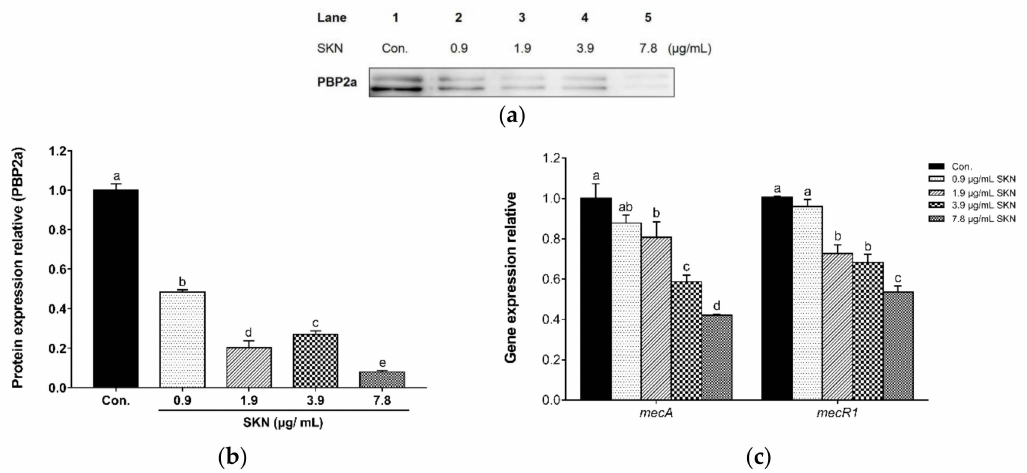
Figure 6. ( a ) The effect of SKN on the protein expression of PBP2a in clinical MRSA strain DPS-1, as analyzed by Western blot. ( b ) The intensities of Western blot protein bands were quantified using ImageJ software. ( c ) The effect of SKN on the mRNA expression of mec operon, as analyzed by qRT-PCR. The data are means ± SD of triplicate determinations. Different letters on the bars indicate significant statistical differences between treatments ( p < 0.05), while the same letters mean no significant differences ( p >